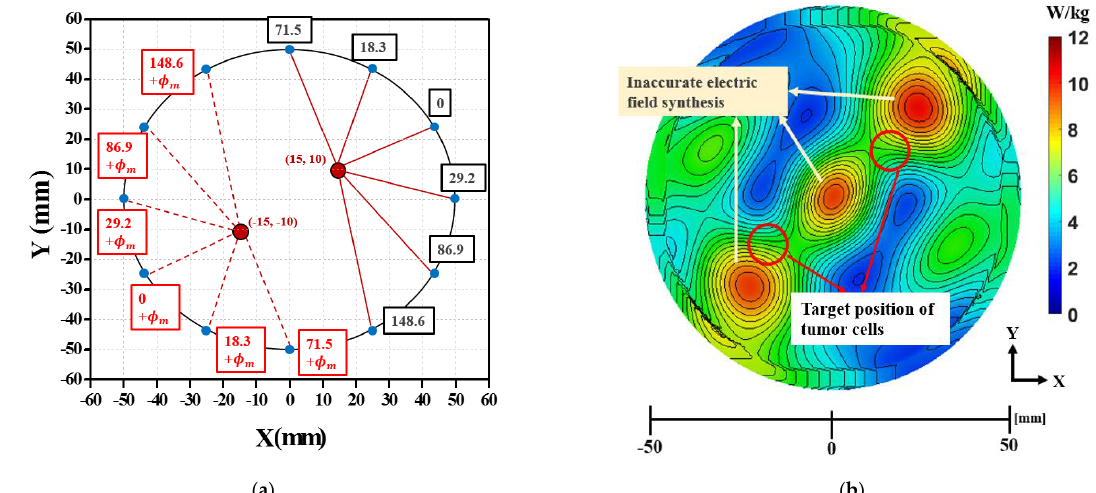
Figure 8. ( a ) Two breast tumor locations at (15,10) mm and ( − 15, − 10) mm, and ( b ) the 2D section of SAR distribution with inaccurate E-field synthesis. Table 3. Calculated input phases with a modified phase for two different breast tumors. Modified